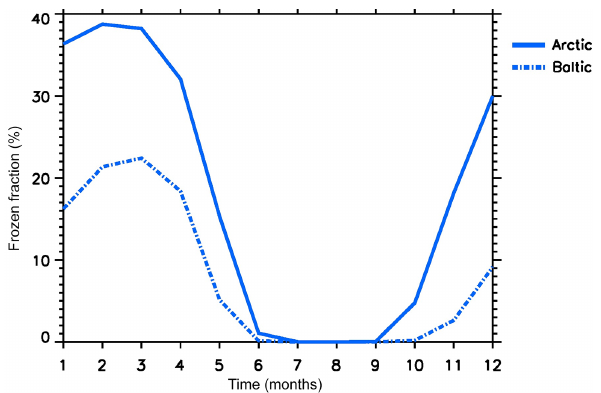
Figure 7. Mean frozen fraction of total root zone soil moisture (1989–2009) in ECH6-PF over the six largest Arctic river catch- ments (solid curve) and the Baltic Sea catchment (land only, dashed